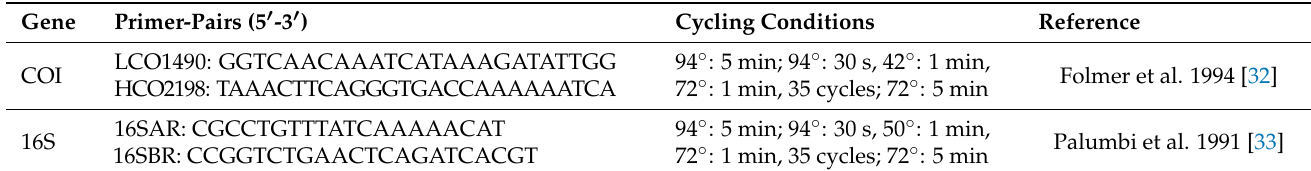
Table 2. The Primer-pairs and PCR conditions used for amplifying the COI and 16S rRNA regions from Macrochlamys indica